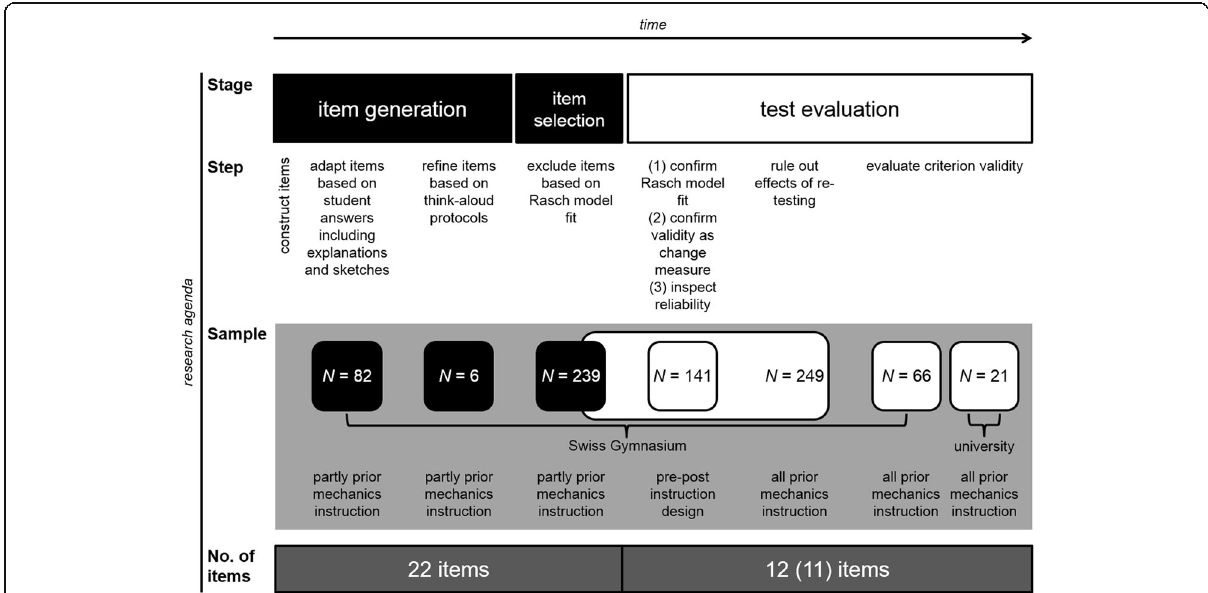
Fig. 1 Schematic representation of the research agenda. Time flows from left to right. Corresponding information is vertically aligned. Rows provide information on the stage within the research process (first row), on the associated steps (second row), on the samples examined in each step (third, gray row), and on the number of items the respective sample worked on (fourth